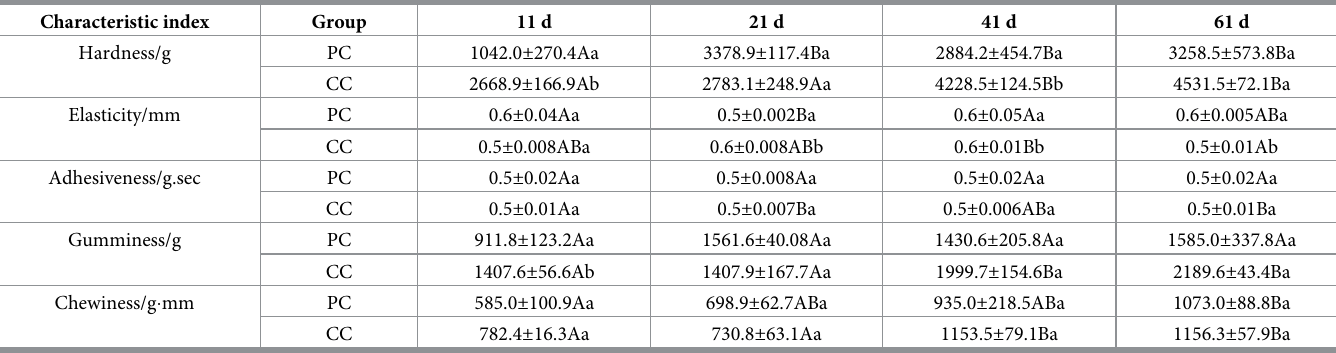
Table 5. Changes of TPA during processing and storage